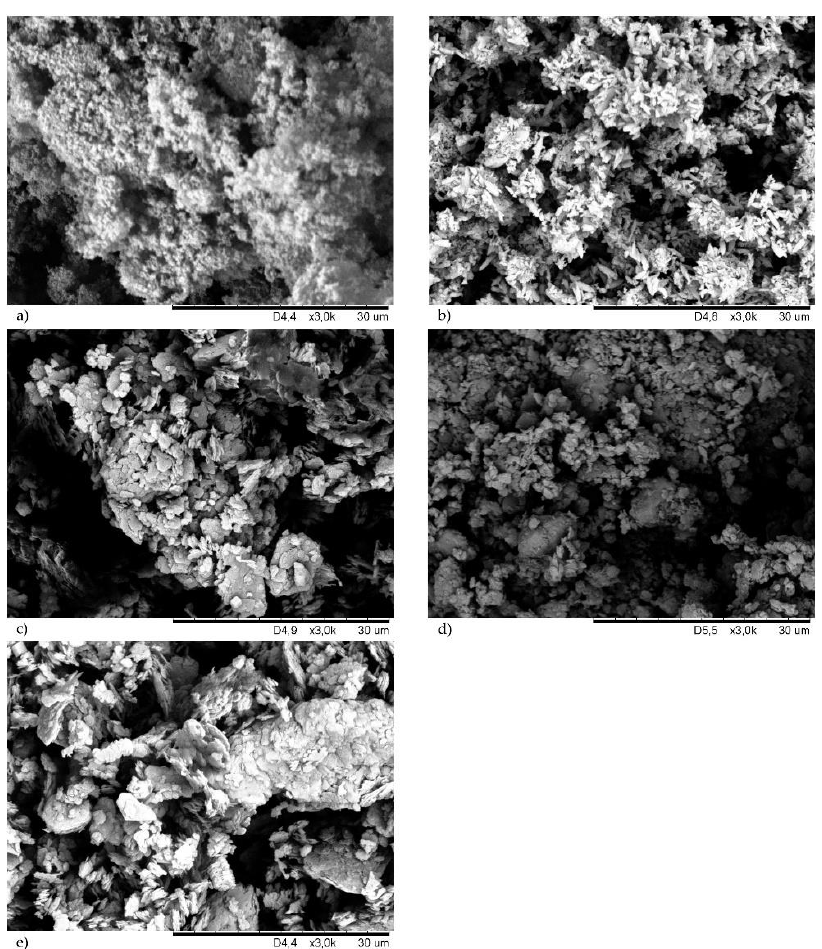
Figure 2. Morphology of fillers: silica ( a ); chalk ( b ); kaolin ( c ); montmorillonite ( d ), carbon black ( e ).